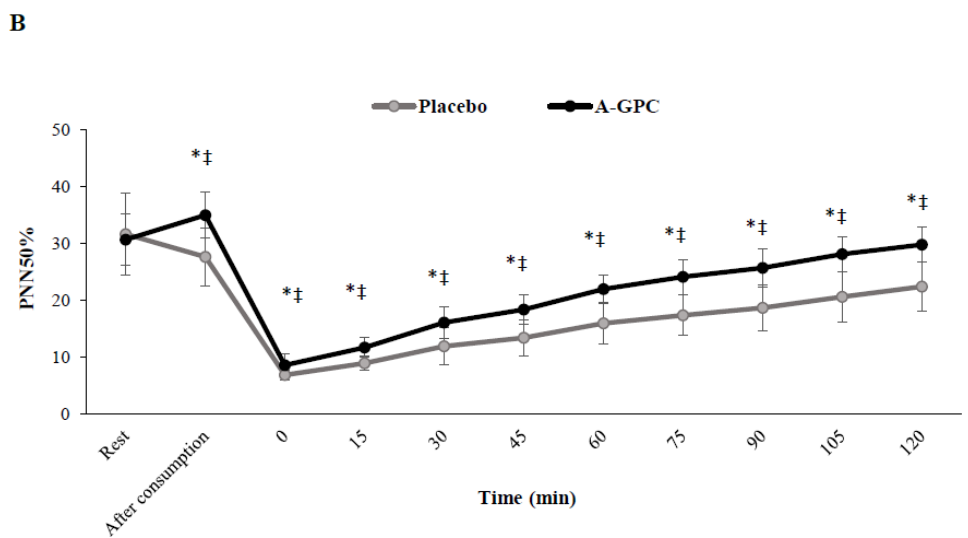
Figure 2. SDNN ( A ) and PNN50% ( B ) at baseline, 60 min after choline or placebo consumption immediately after exercise and every 15 min after exercise. SDNN, Standard Deviation of RR wave intervals; pNN50%, percentage of interval differences of adjacent RR intervals greater than 50 ms. Values are means ± SD. * indicates a significant difference from baseline ( p < 0.05); ‡ indicates a significant difference from placebo ( p < 0.05).